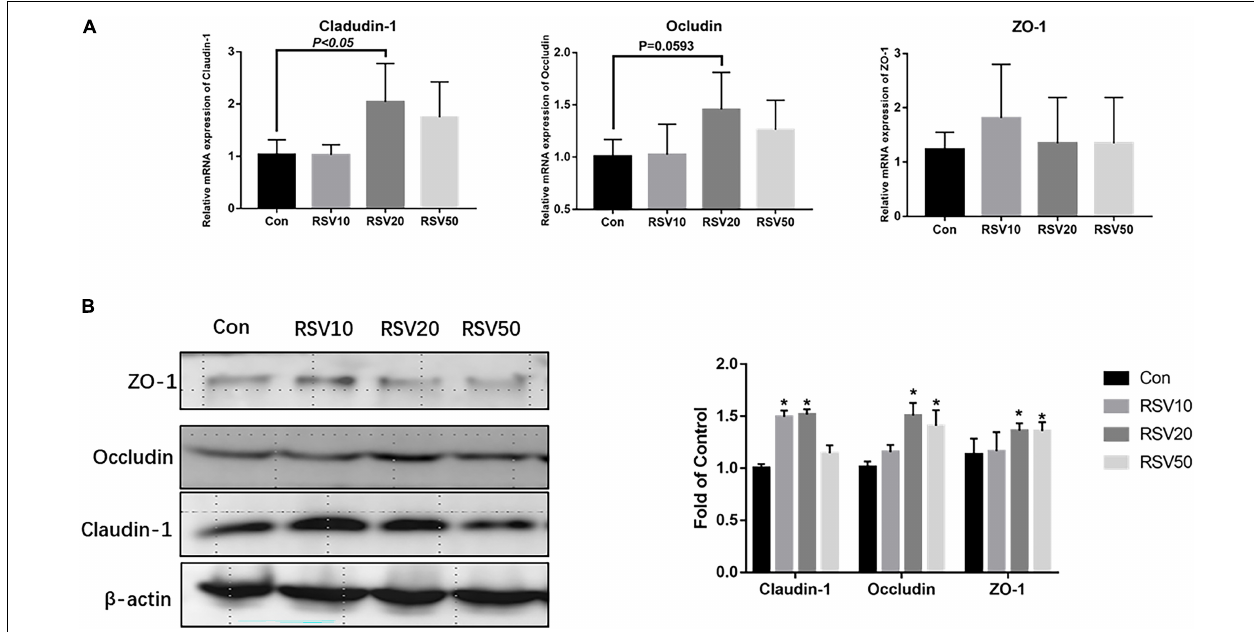
FIGURE 3 | Effect of RSV on the levels of intestinal barrier proteins in weaned mice. (A) The relative mRNA expression of claudin-1, occludin, and ZO-1 was detected by qRT-PCR. (B) The protein levels of Claudin-1, Occludin and ZO-1 were detected by Western blot with β -actin as the loading control. Con = control